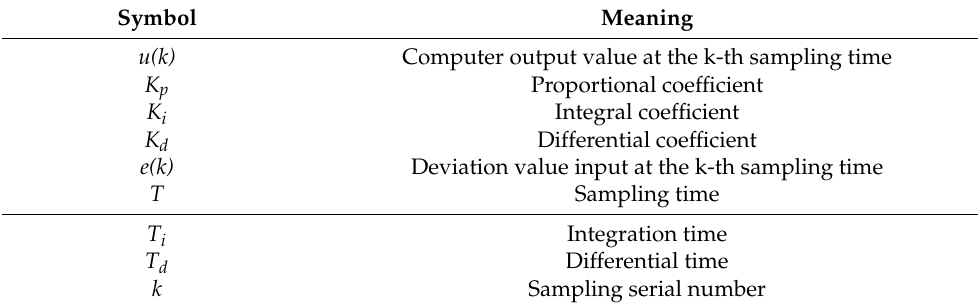
Table 3. Symbols and definitions.